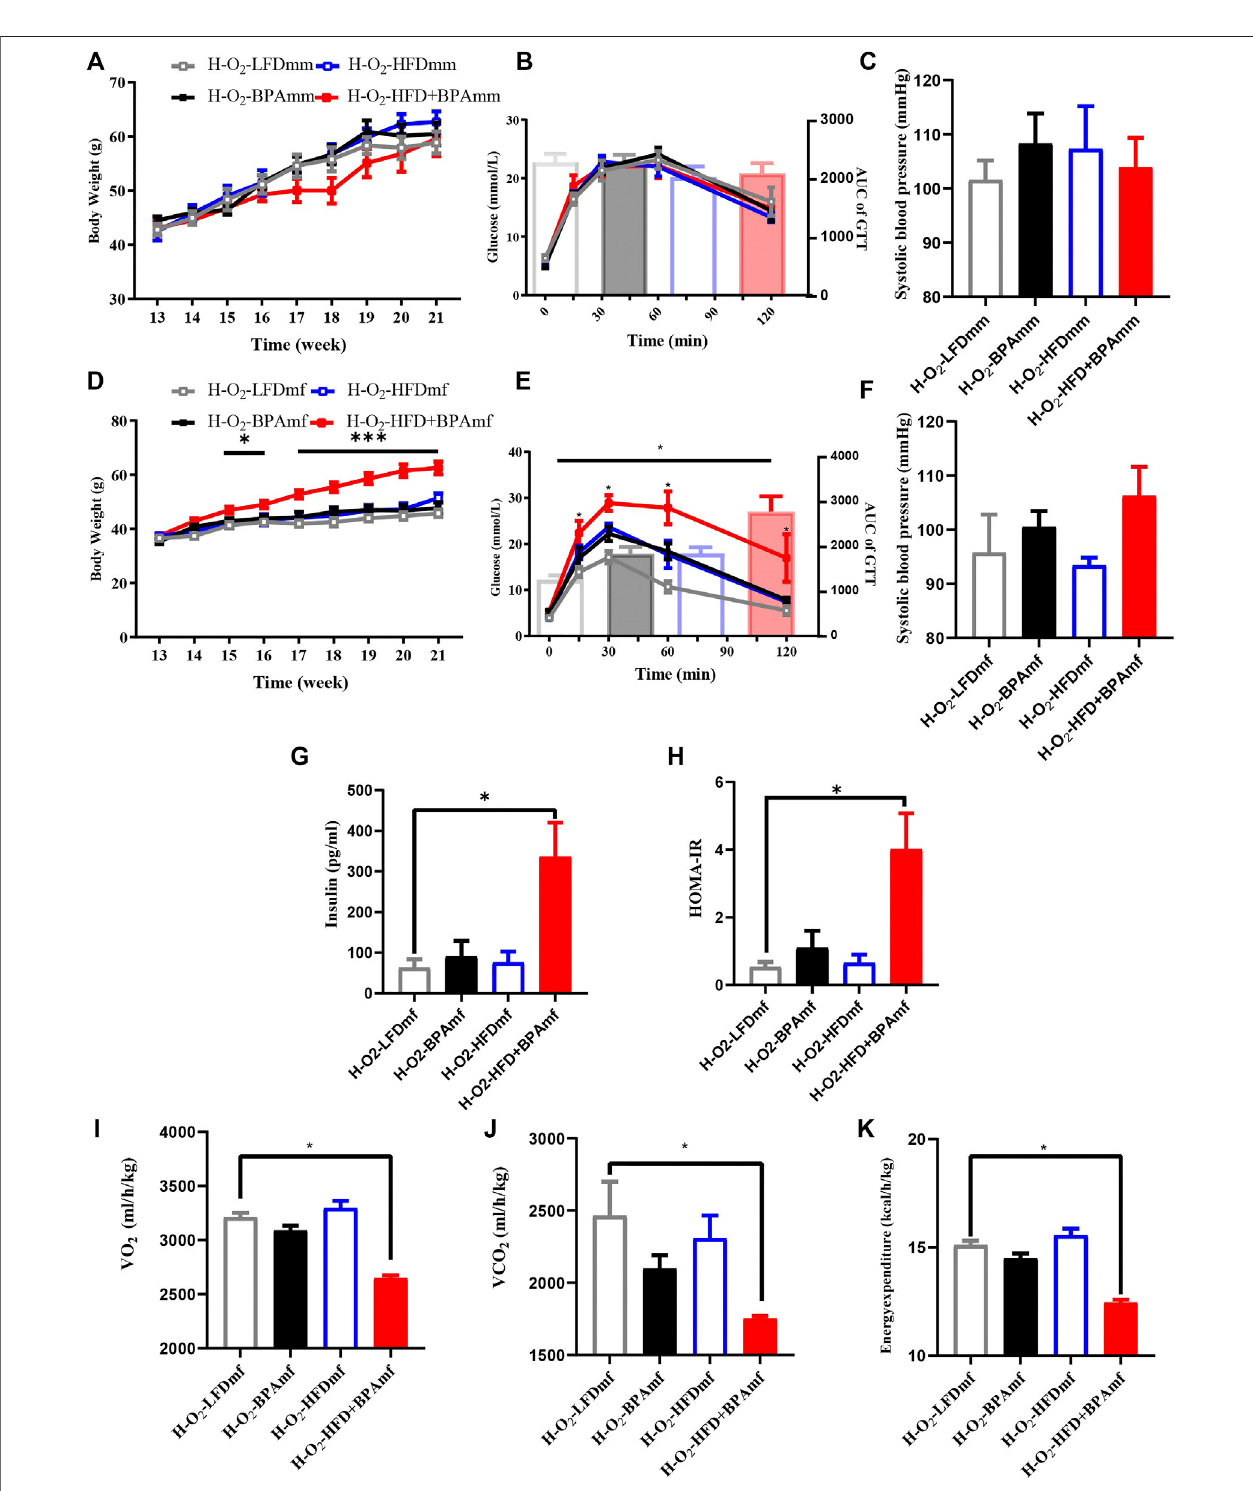
FIGURE 5 | HFD, BPA and their combination affect weight gain, metabolic pro fi le and blood pressure of patrilineal F2 with HFD. (A – C) Body weight, glucose tolerance and systolic blood pressure of patrilineal male F2 with HFD. (D – F) Body weight, glucose tolerance and systolic blood pressure of females and males of patrilineal female F2 with HFD. (G,H) Serum insulin concentration and HOMA-IR of patrilineal female F2 with HFD. (I – K) metabolism cage of patrilineal female F2 with HFD. Data are means ± SEMs and were analyzed by two-way ANOVA with a posthoc test. * p < 0.05, *** p < 0.001, BPA, HFD, BPA + HFD vs. LFD.